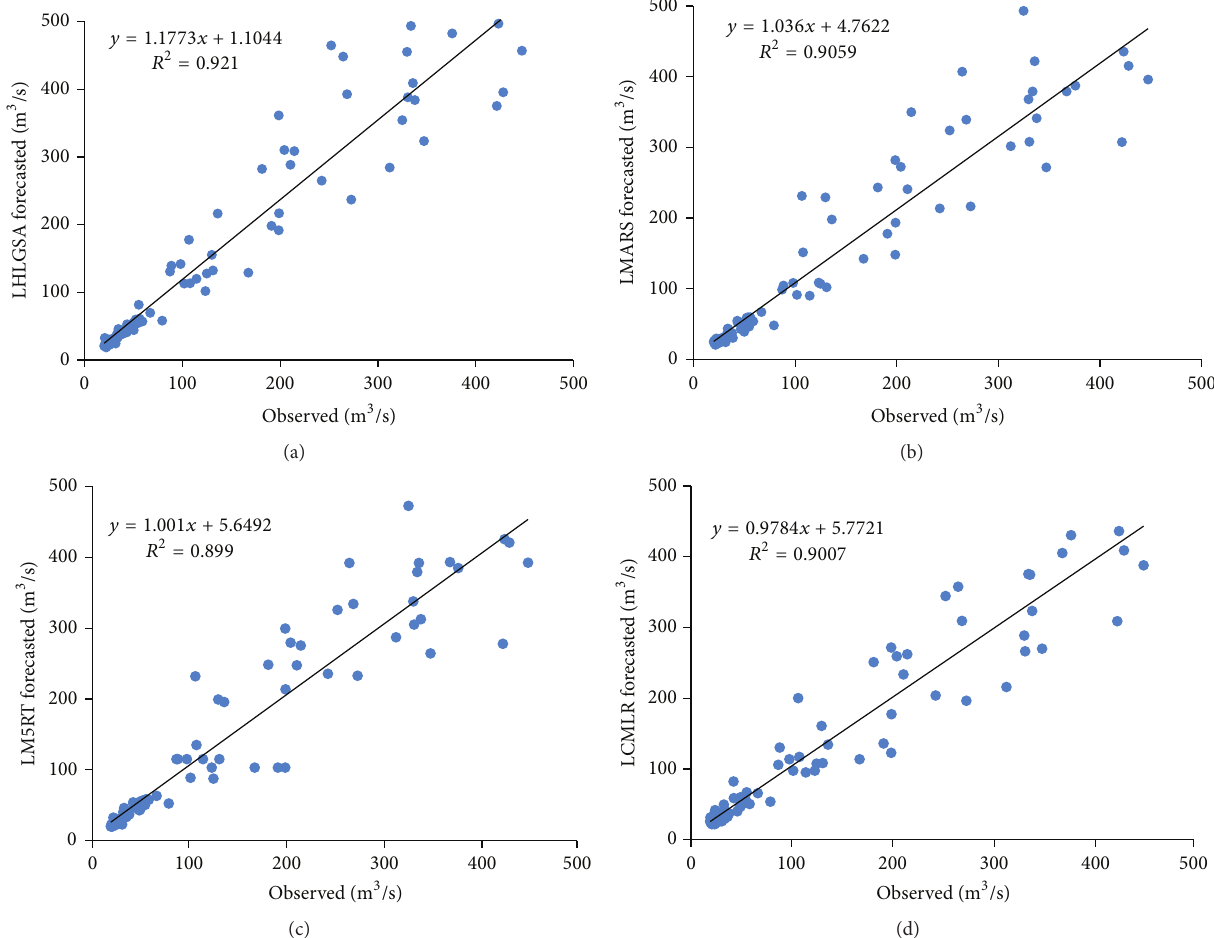
Figure 10: The observed and forecasted river flow by the LHLGSA, LMARS, LM5RT, and LCMLR models using DS4 data set: Astore catchment.